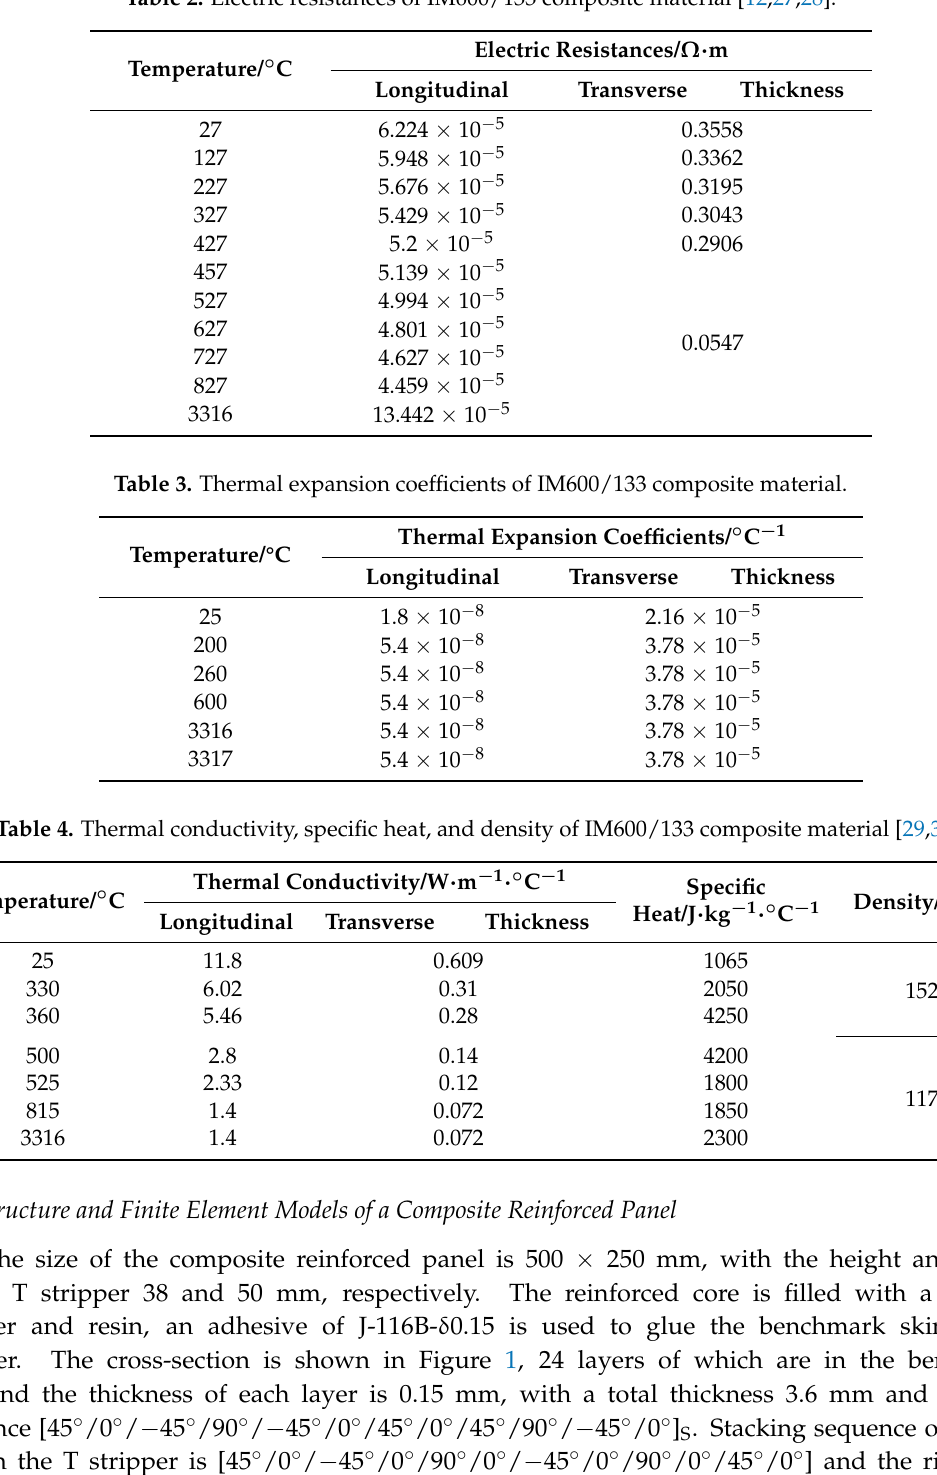
Table 2. Electric resistances of IM600/133 composite material [12,27,28].